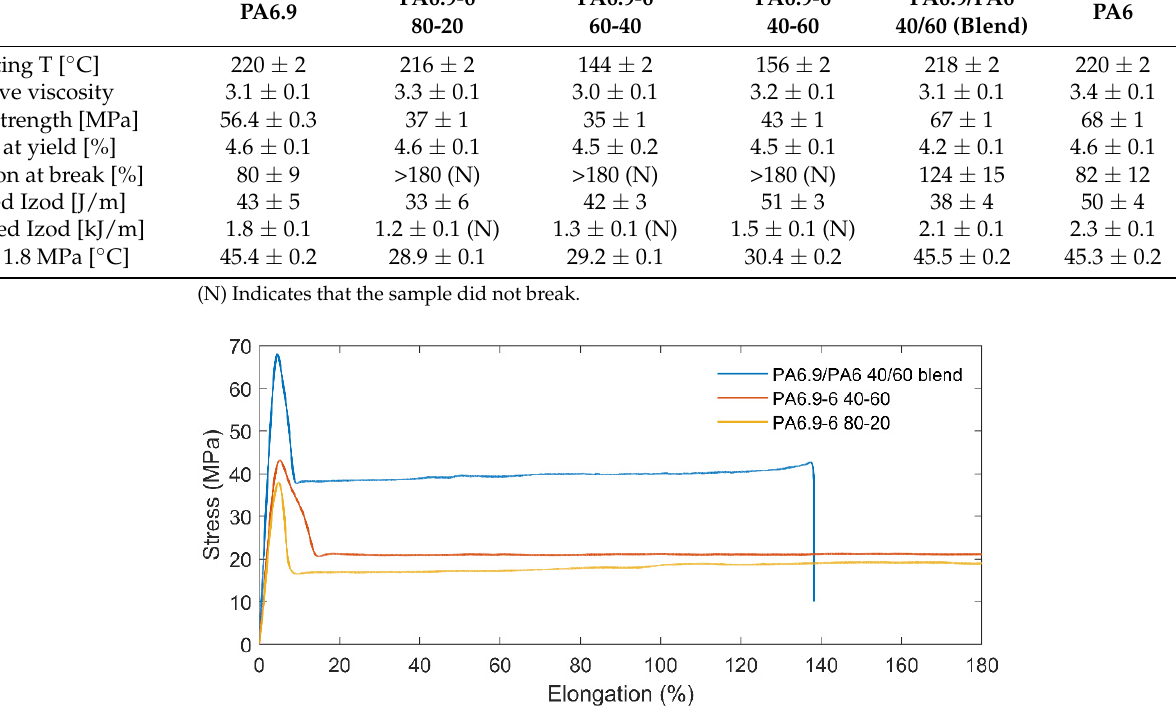
Figure 7. Examples of stress-strain curves for blended PA6/PA6.9 and for two different copolymers.